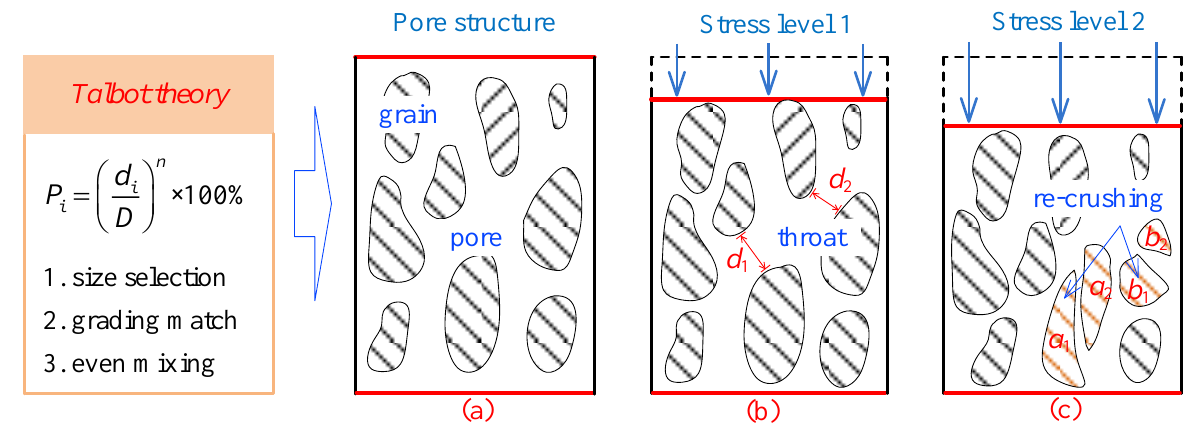
Figure 2. Compaction-deformation process of broken structural coal rock particles. ( a ) Initial pore status; ( b ) Pressurization process; ( c ) Compaction deformation.